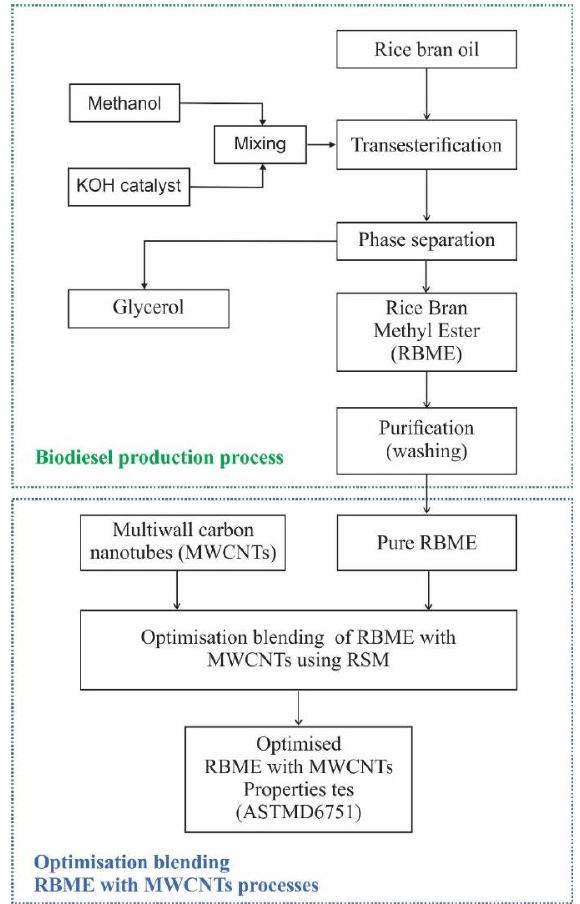
Figure 2. Flow chart of rice bran methyl ester (RBME) production and blending process of RBME and multi-walled carbon nanotubes (MWCNTs) .